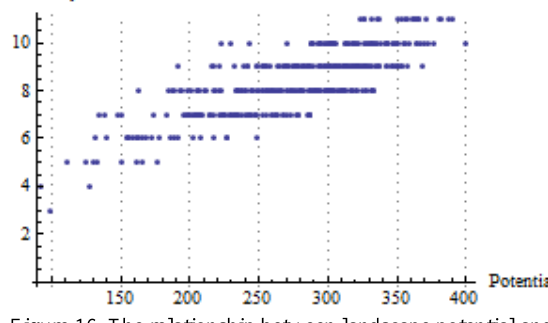
Figure 16. The relationship between landscape potential and